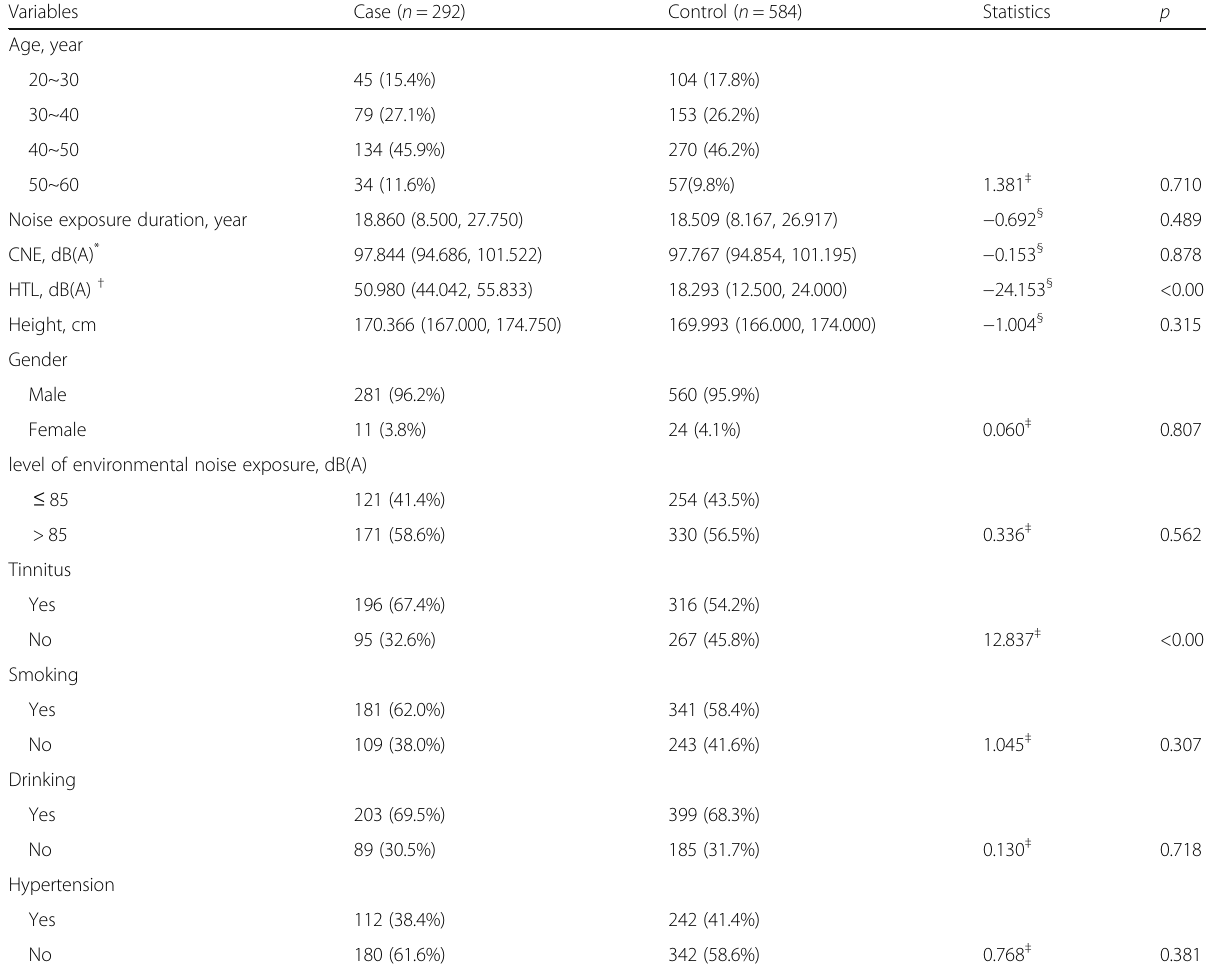
Table 1 Basic Information Distribution in Case and Control